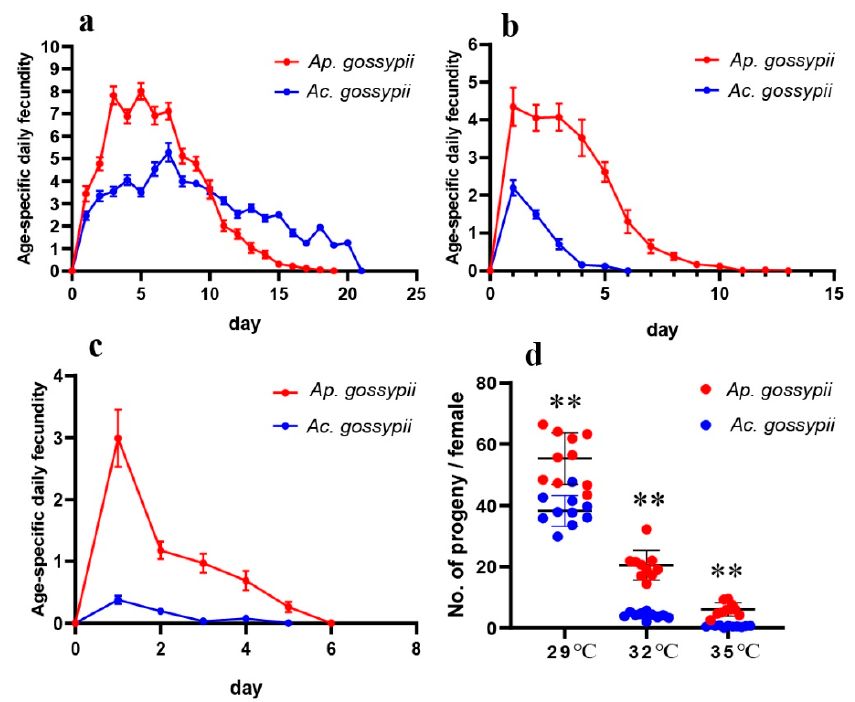
Figure 3. Age-stage-specific fecundity of adults of Aphis gossypii and Acyrthosiphon gossypii at differ- ent temperatures. ( a ) 29 °C; ( b ) 32 °C; ( c ) 35 °C; and ( d ) the scatter diagram of progeny per female. The results from two independent groups of fecundity were assessed using Student’s t-test. The error bars indicate standard error (SE). **, p < 0.01.